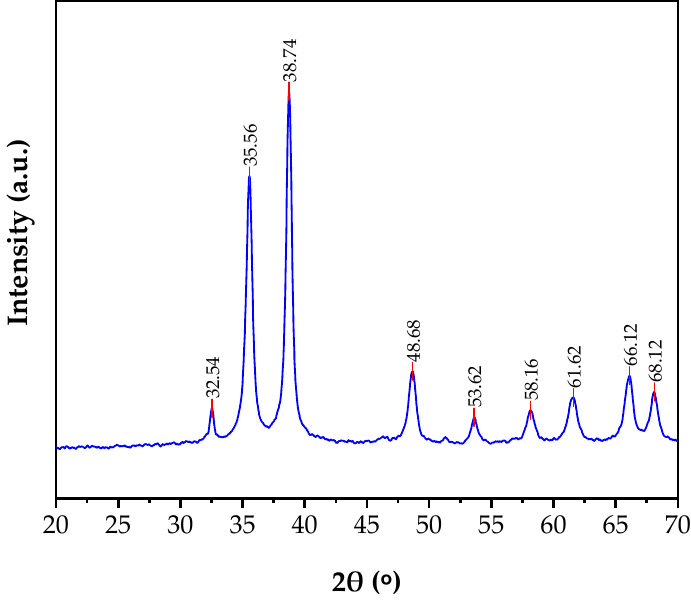
Figure 3. XRD pattern of the solid product obtained from UV-Ozone process.